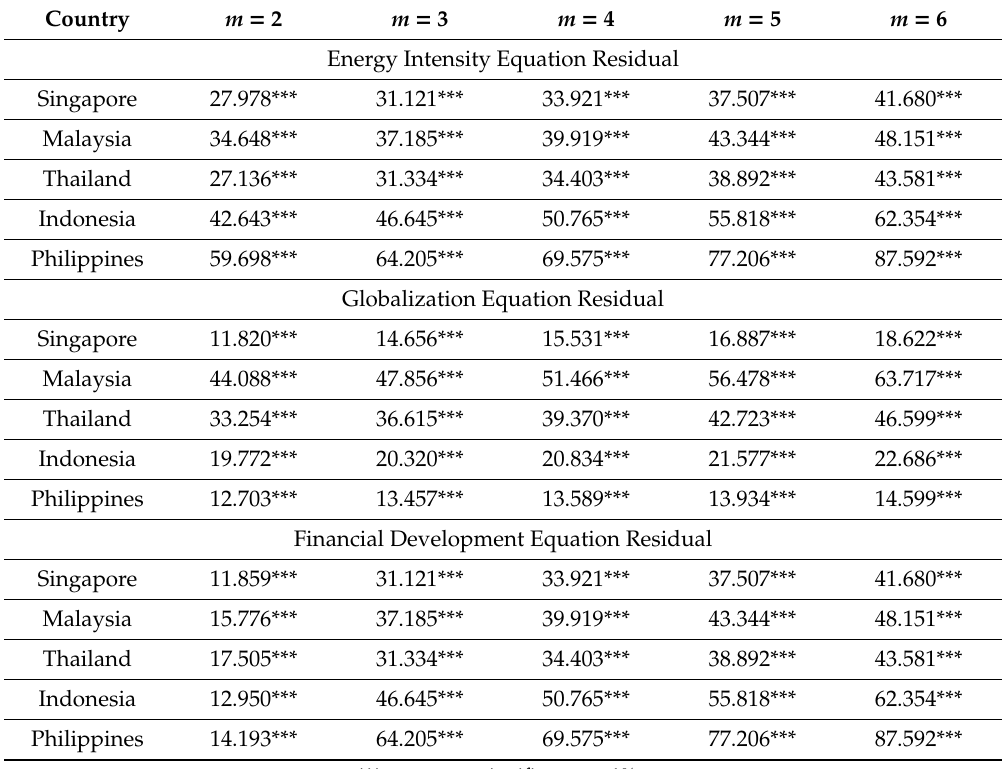
Table 3. Results of BDS test for nonlinearity.